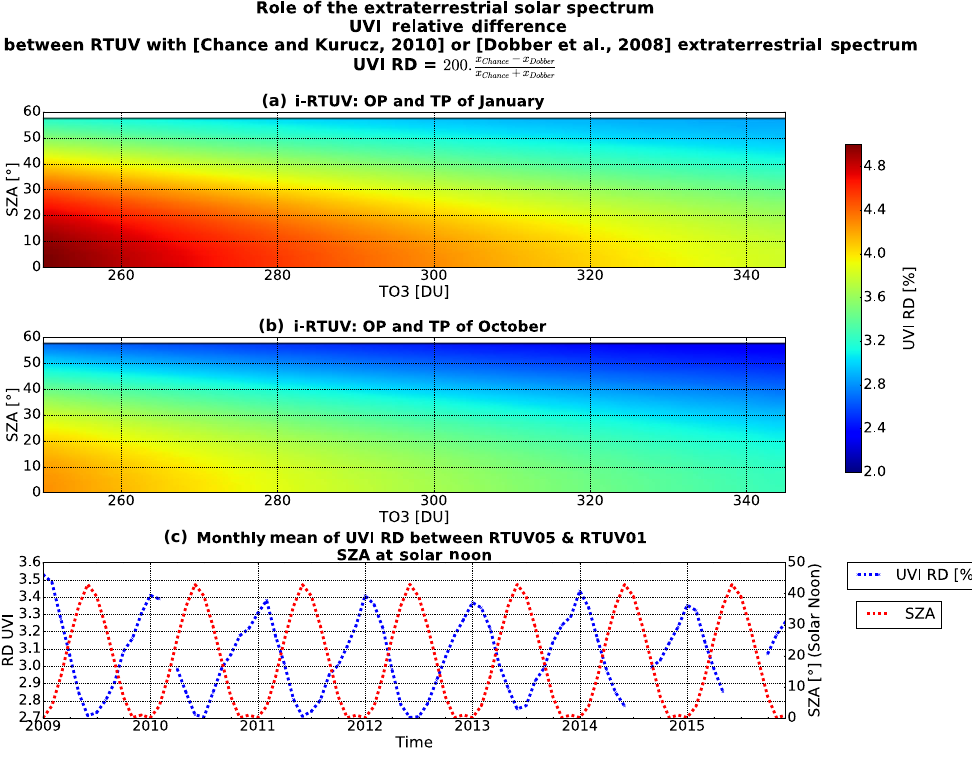
Figure 4. (a) UVI relative difference between two idealised runs with different ET spectra for a varying TO 3 and SZA for a climatological OP and TP of January. (b) Same as panel (a) but for OP and TP of October. (c) Monthly mean of UVI RD between RTUV05 and RTUV01 (blue dashed line). Monthly mean of SZA at solar noon. (red dashed